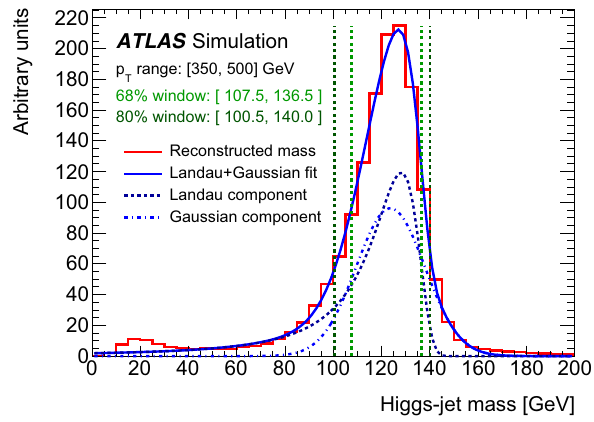
Fig. 4 The Higgs-jet mass distribution for jet transverse momenta in therange350to500GeVafterreweightingthe p T spectrum.Thedotted and dash-dotted blue curves correspond to the two components of the fit function, while the solid blue curve shows the combination thereof. The vertical lines indicate the boundaries of the mass ranges for 68% (light green) and 80% (dark green) containment